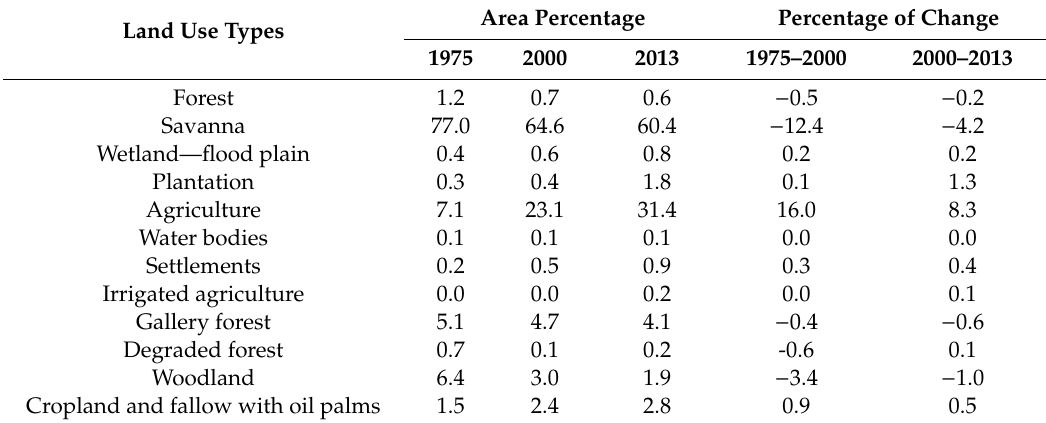
Table 1. Percentage of change in land use and land cover within 1975–2000 and 2000–2013.